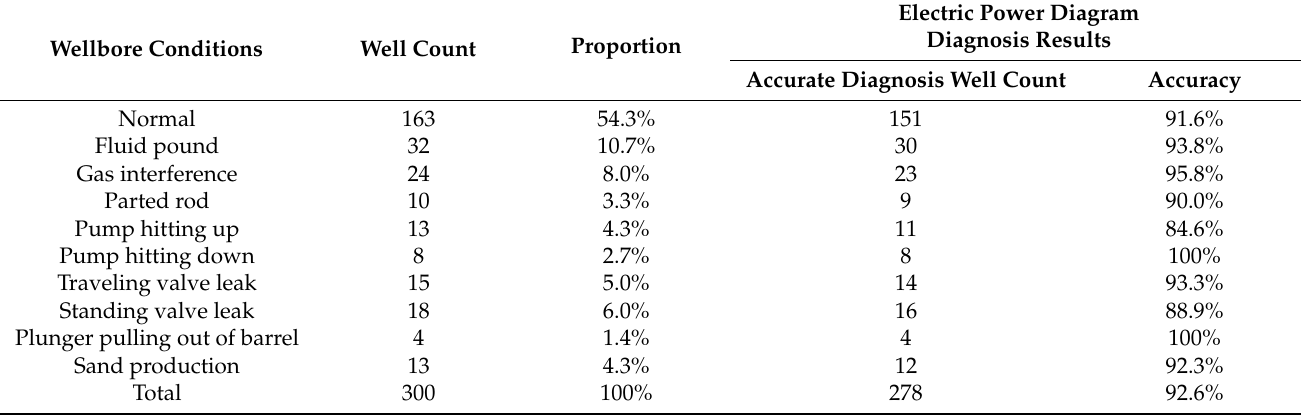
Table 5. Diagnosis results of wellbore condition.